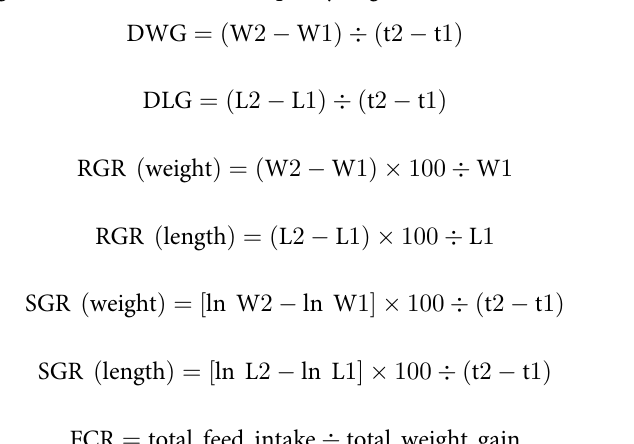
30 0 where LJ and UJ are the lengths of the upper and lower jaw, respectively [10, 11]. Water quality parameters were monitored every 10 th day during the culture period. Key water quality parameters like temperature, pH, salinity, dissolved oxygen, turbidity, and ammonia were moni- tored and analyzed using a handheld multi-parameter kit (YSI professional plus, USA) and stan- dard protocols [12]. The water samples were collected just before the sunrise on sampling days. Estimation of growth parameters Sampling was done at intervals of 10 days over a grow-out operation of 100 days using cast net (30mm mesh size) to assess the well-being and growth of the fish. Mean total length (nearest mm) and mean weight (nearest 0.1 g) were estimated for each sampled fish. Length-weight relationship of a fish is usually expressed by the equation, W = aL b [13] where W is body weight (g), L is total length (cm), a is the coefficient related to body form, and b is an exponent indicat- ing isometric growth when equal to 3 [14]. The parameters a and b were estimated by the least- square method from logarithmically transformed length and weight attributes and the associa- tion degree between weight-length variables was assessed using a correlation coefficient ( R 2 ). Fulton’s condition factor (K = W � 100/ L3; where W and L are observed weight and length) was estimated to assess the condition of individual sampled fish [15]. Observed weight is also compared against the estimated weight from the length-weight relationship established from wild-caught specimens in order to assess the growth performance in captivity against their wild counterpart [16]. Growth performance parameters viz ., daily weight gain (DWG), daily length gain (DLG) relative growth rate (RGR), specific growth rate (SGR), and feed conversion ratio (FCR) were also estimated as given below to evaluate the quality of growth [17].